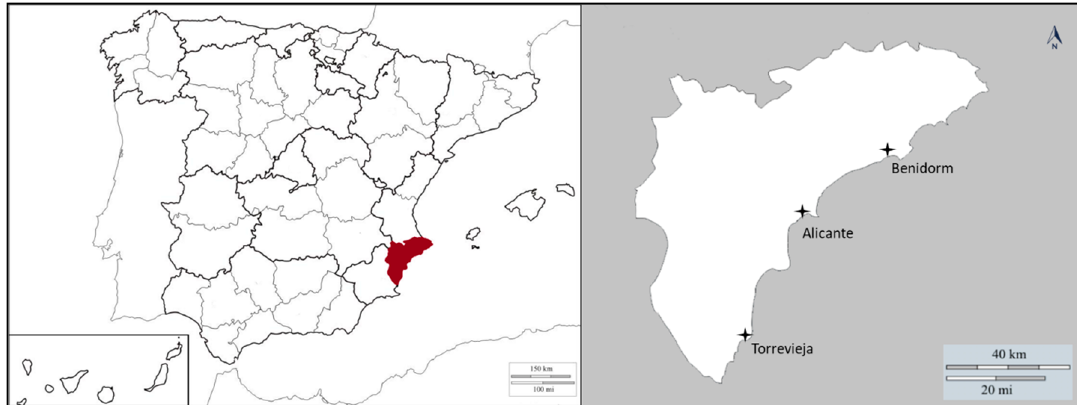
Figure 1. Location of the cases studied.